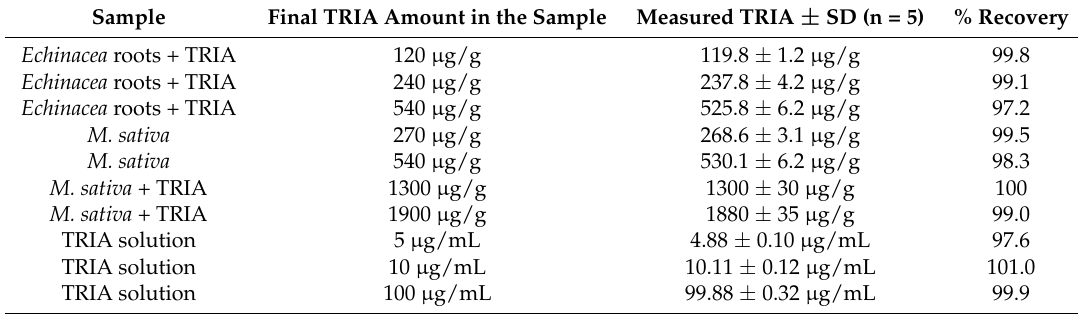
Table 3. Recovery of TRIA added to solid and liquid samples. TRIA was added to dried Echinacea roots and two samples of dried M. sativa to evaluate method